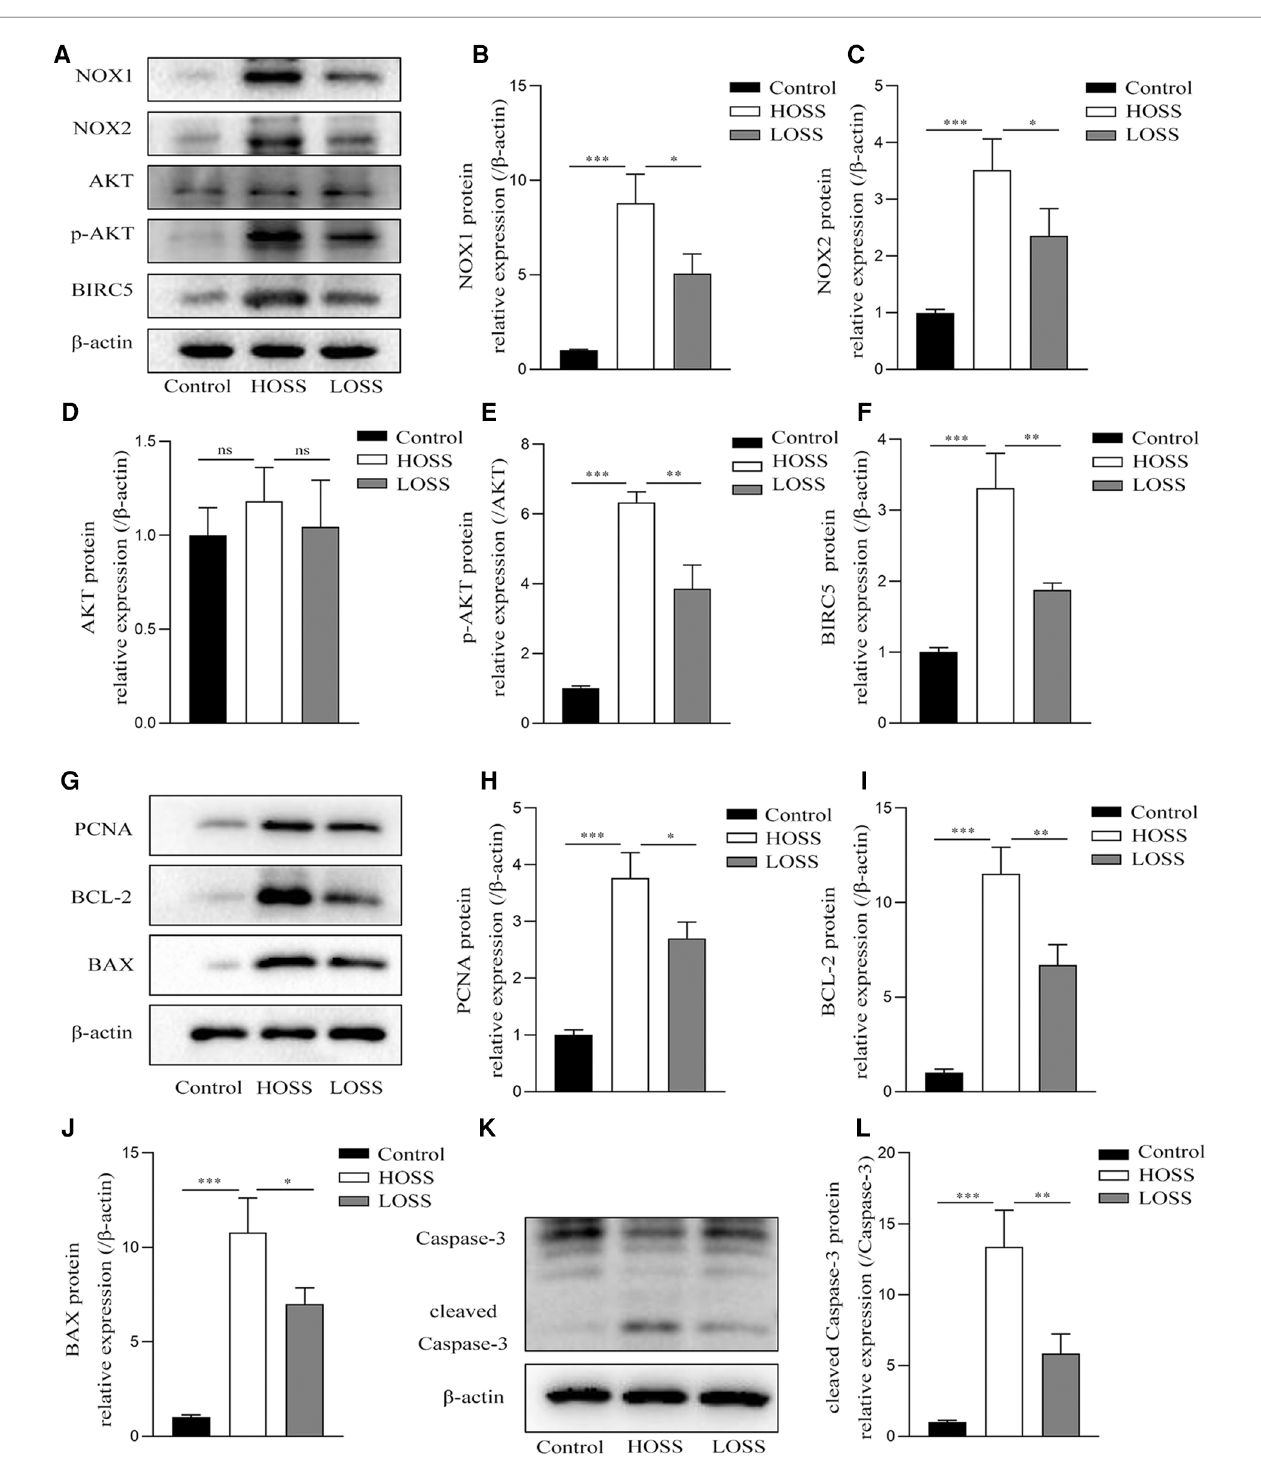
FIGURE 6 Oscillatory shear stress (OSS) is involved in altering NOX-AKT-BIRC5 signaling, cell proliferation, and apoptotic factor expression. Western blotting of puri fi ed protein lysates from grafted veins was used to detect protein expression. ( A – F ) OSS was positively correlated with the expression of NADPH oxidase-related proteins in grafted veins. ( G – L ) High OSS (HOSS) promoted the expression of proliferative, apoptotic, and anti-apoptotic related proteins, whereas decreasing the shear level attenuated their expression. Experiments were repeated in triplicate. * P <0.05; ** P <0.01; *** P <0.001; ns: no signi fi cant